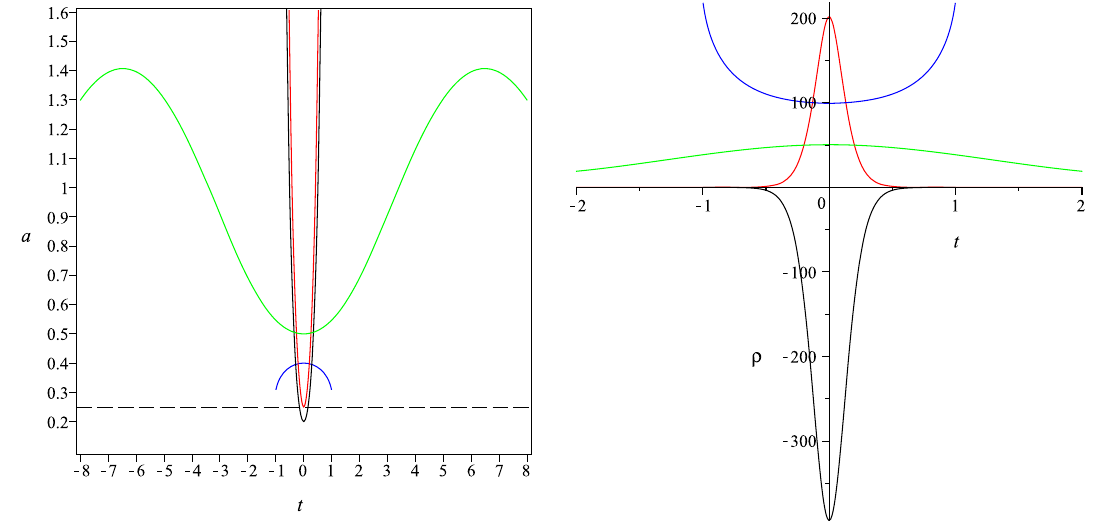
Fig. 2 Time evolution of the scale factor a and energy density ρ , corresponding to the different initial conditions in phase space for the case of γ = 0, k = 1, α = 1 and β = 0 . 05